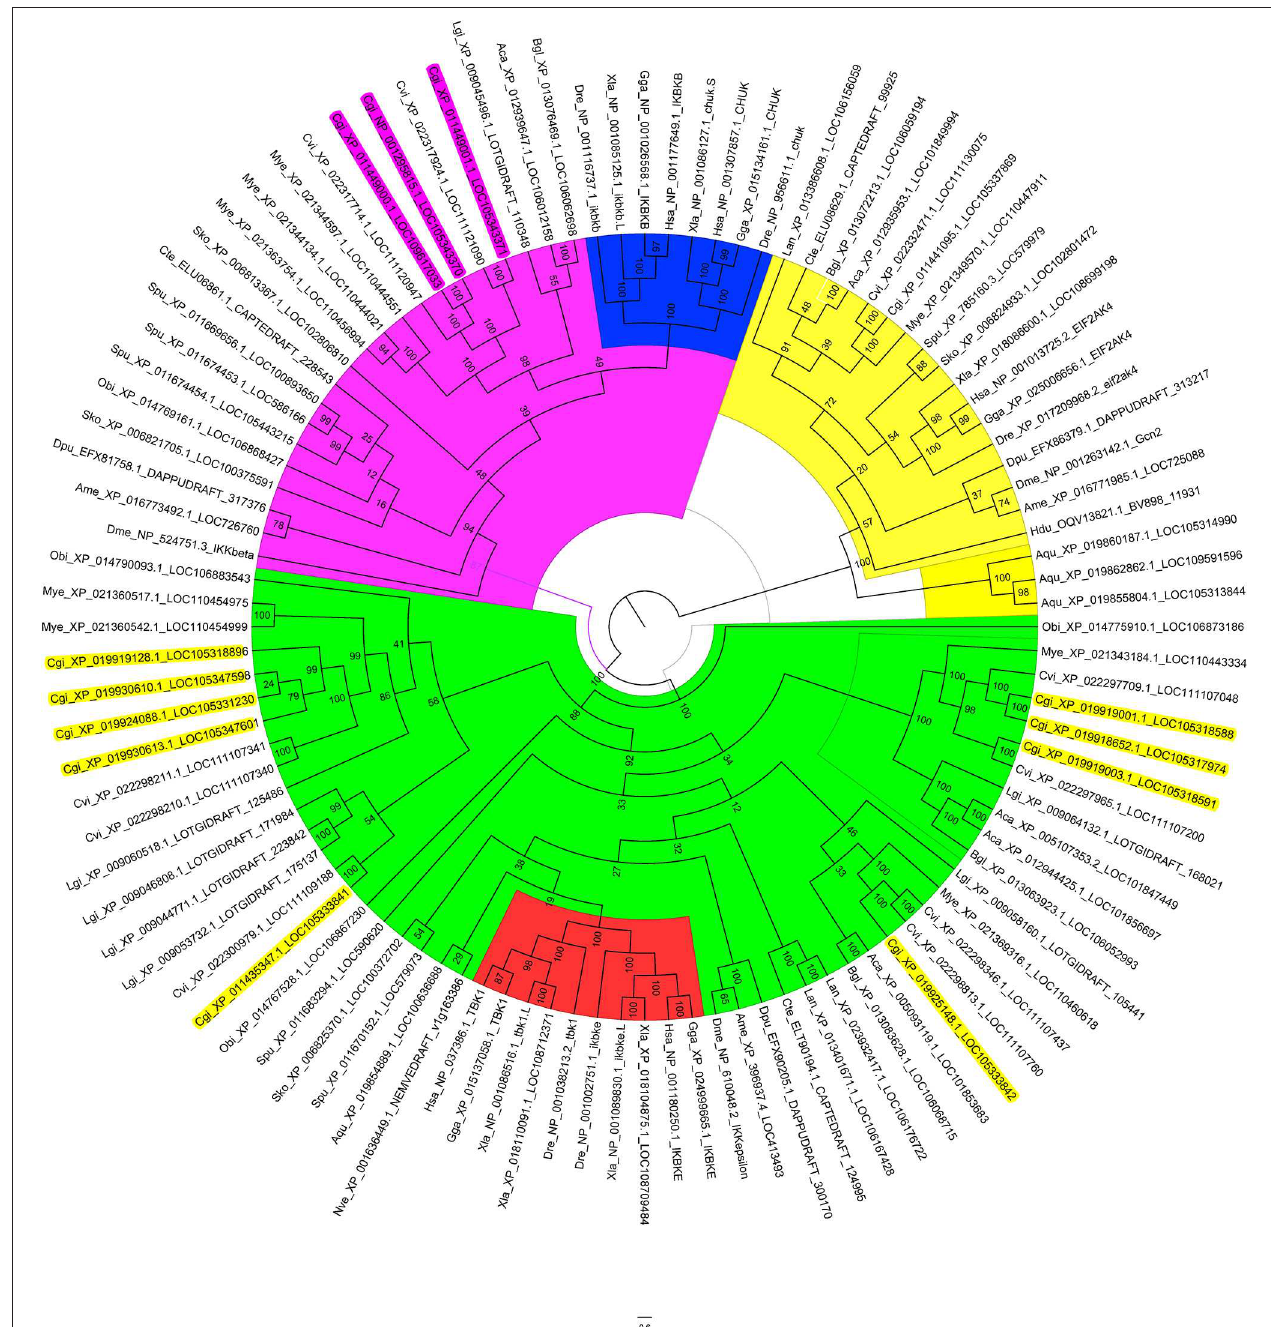
FIGURE 1 | Phylogenetic tree of IKKs and IKK-related kinases from various species. The phylogenetic tree is divided into three branches: in pink are IKK α /IKK β family members, in green are TBK1/IKK ε family members, and in yellow are the outgroup sequences. Blue indicates the vertebrate IKK α and IKK β branches. Red indicates the vertebrate TBK1/IKK ε branches. The names of oyster IKKs and IKK-related kinases are shown in pink and yellow, with pink indicating oyster IKK α / β proteins, and yellow indicating oyster IKK ε or IKK ε -like proteins.